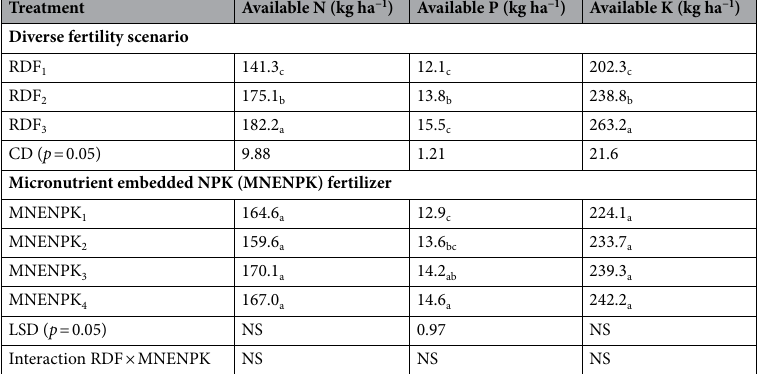
Table 1. Effect of diverse fertility scenarios and MNENPK treatments on soil after two eggplant crops. Means followed by a similar lowercase letter within a column are not significantly different at p < 0.05 according to Tukey’s HSD test; NS = non-significant; data are pooled means of 2017–2018 and 2018–2019 cropping seasons.